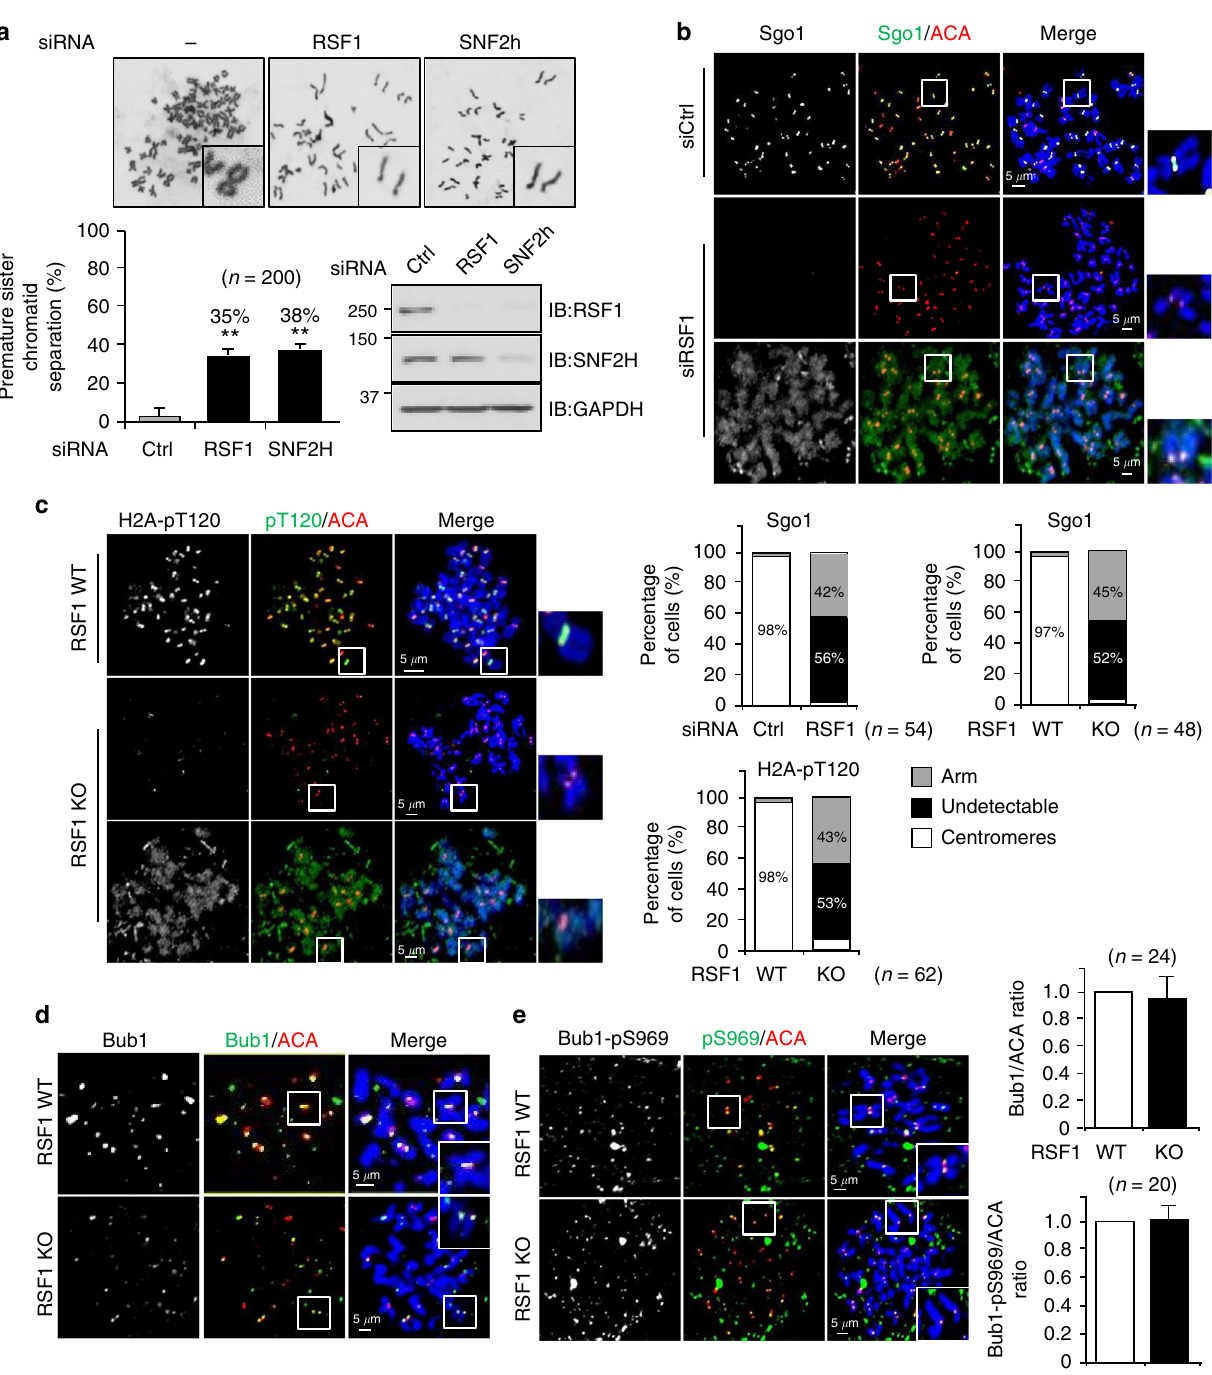
Fig. 1 RSF1 is necessary for restricting H2A-pT120 and Sgo1 to centromeres. a HeLa cells were transfected with siRNAs, and fl oating mitotic cells were obtained after nocodazole treatment for 4 h and subjected to metaphase chromosome spread stained with Giemsa. Quanti fi cation of sister chromatid separation in HeLa cells after depletion of RSF1 or SNF2H. Data represent mean ± SEM; ** p < 0.01 vs. control siRNA by Student ’ s t -test. b HeLa cells were transfected with siRNAs, and RSF1-depleted cells were subjected to chromosome spread immunostaining. Images were obtained from representative mitotic cells: Sgo1 (green), ACA (red), and DAPI (blue). The percentages of cells exhibiting the arm or centromeric localizations of Sgo1 proteins are shown. Scale bar, 5 μ m. c RSF1 knockout mitotic cells were analyzed by immuno fl uorescence staining: H2A-pT120 (green), ACA (red), and DAPI (blue). Percentage of cells exhibiting the arm or centromeric expression level of H2A-pT120 are shown. Scale bar, 5 μ m. d Localization of Bub1 on mitotic chromosomes in RSF1 WT or knockout (KO) cells. Nocodazole-treated, mitotic RSF1 WT or knockout (KO) HeLa cells were stained with DAPI and the Bub1 antibodies. The graph represents relative intensity of Bub1 against ACA at kinetochores. At least 100 kinetochores of prometaphase cells were analyzed in three independent experiments. Scale bar, 5 μ m. e Metaphase chromosome spreads were stained with anti-Bub1-pS969 and anti-ACA in RSF1 WT or KO cells. Cells were stained with DAPI and the Bub1-pS969-speci fi c antibodies. The graph represents relative intensity of Bub1-pS969 against ACA at kinetochores. At least 100 kinetochores of prometaphase cells were analyzed in three independent experiments. Scale bar, 5 μ